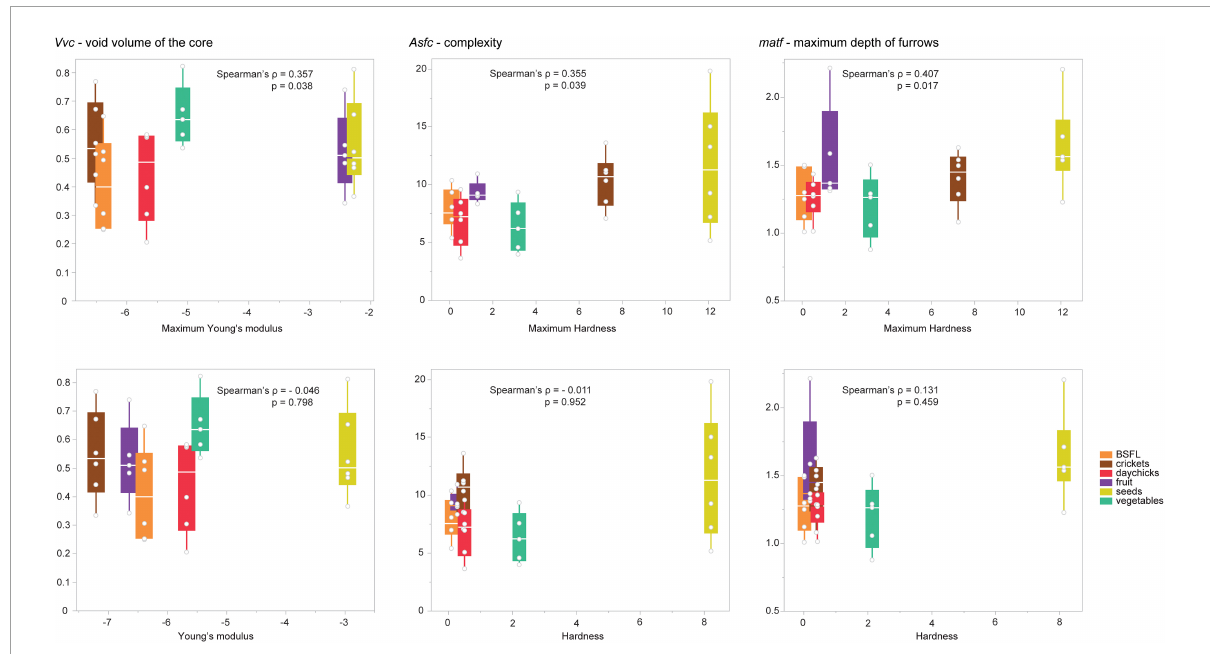
FIGURE4 Correlations of selected DMTA parameters were obtained from the first upper molar (M1) of all rat diet groups with Young’s modulus and TPA hardness. The upper row shows a correlation with the maximum Young’s modulus and maximum TPA hardness per diet, and the lower row shows a correlation with the mean Young’s modulus and the mean TPA Hardness per diet. Note that correlations are stronger and significant for maximum mechanical properties (upper row) only. Young’s modulus is shown log-transformed for better visualization. BSFL, black soldier fly larvae.